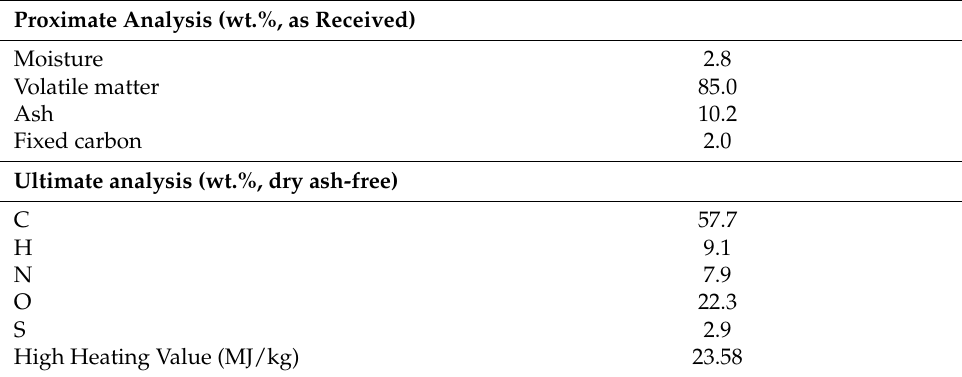
Table 1. Fuel properties of the dried AMR material.